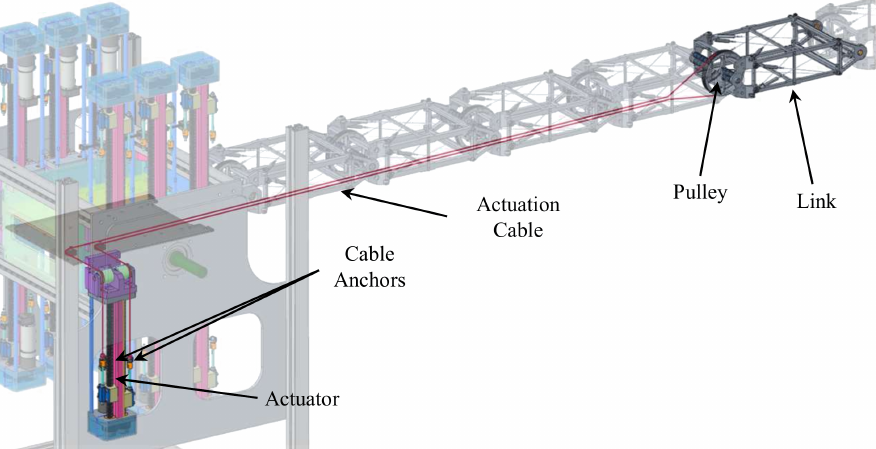
Figure 8. Schematic view of the actuation system. For each joint a couple of counteracting cables are routed from a linear actuator on the base up to a pulley along the robotic